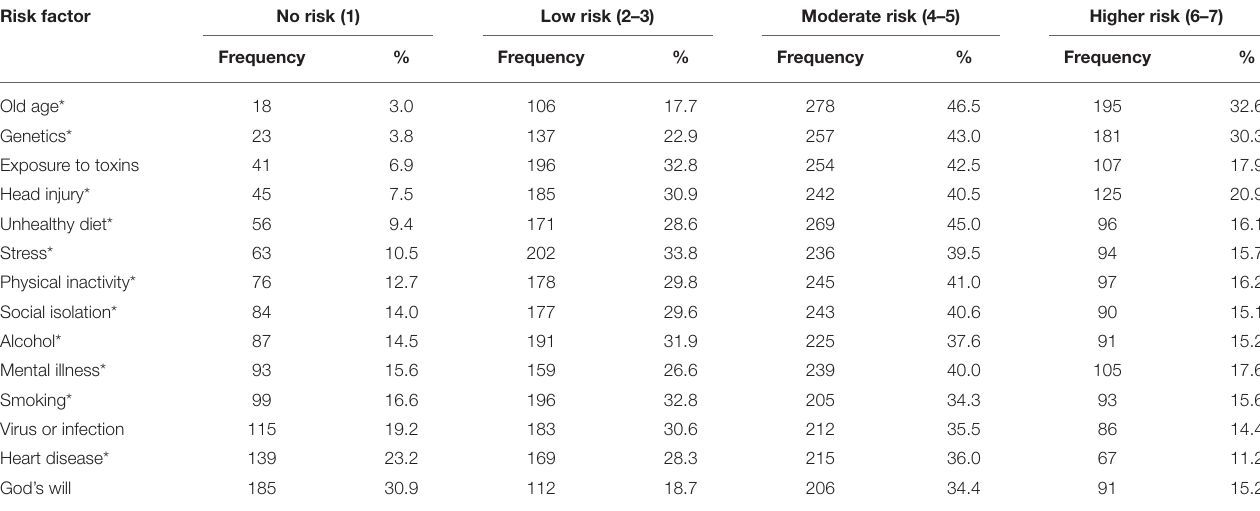
* Indicates the eleven empirically supported factors for increased dementia